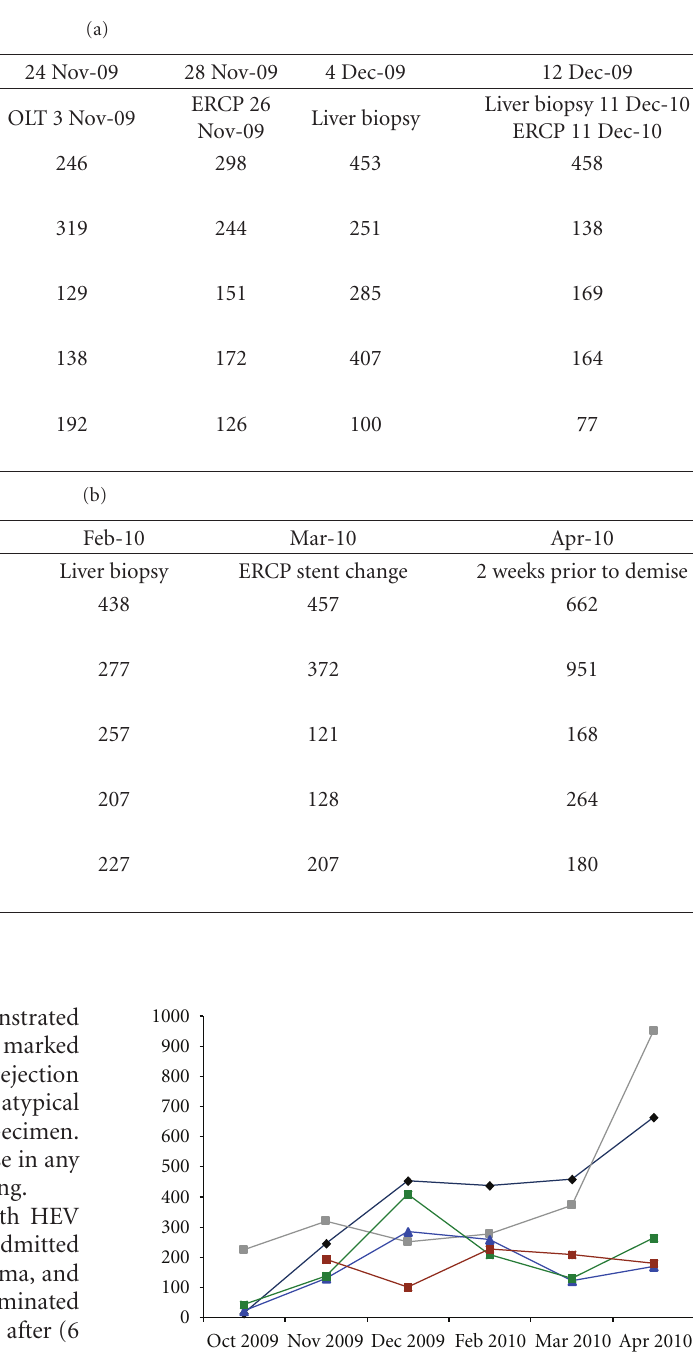
Table 1: Serial liver tests for patient Mr. X.